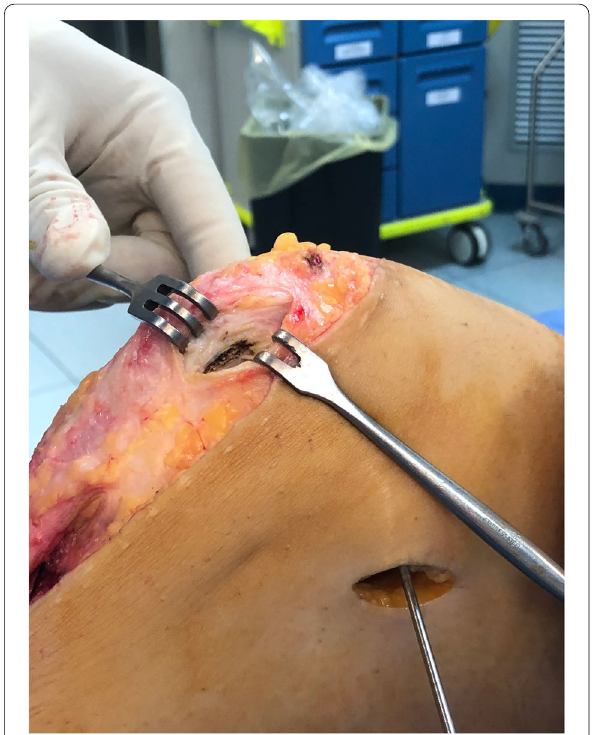
Fig. 3 Fixation with an interference reabsorbable screw (7 with the knee at 30° of flexion and neutral